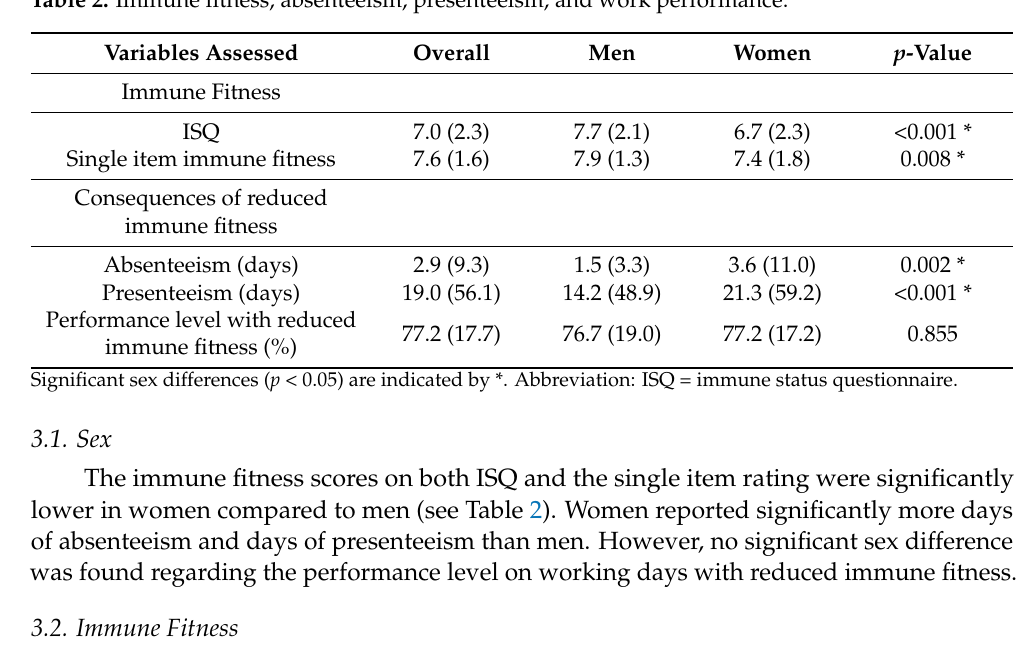
Table 2. Immune fitness, absenteeism, presenteeism, and work performance.